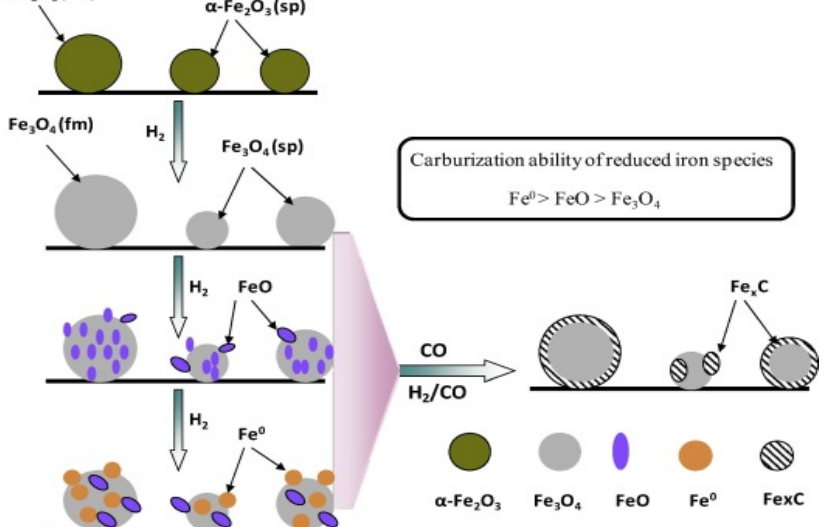
Figure 4. Carburization behaviors of different reduced iron phases for the iron-based catalyst. Reproduced from Ref. [42] with copyright license from Elsevier (2021).